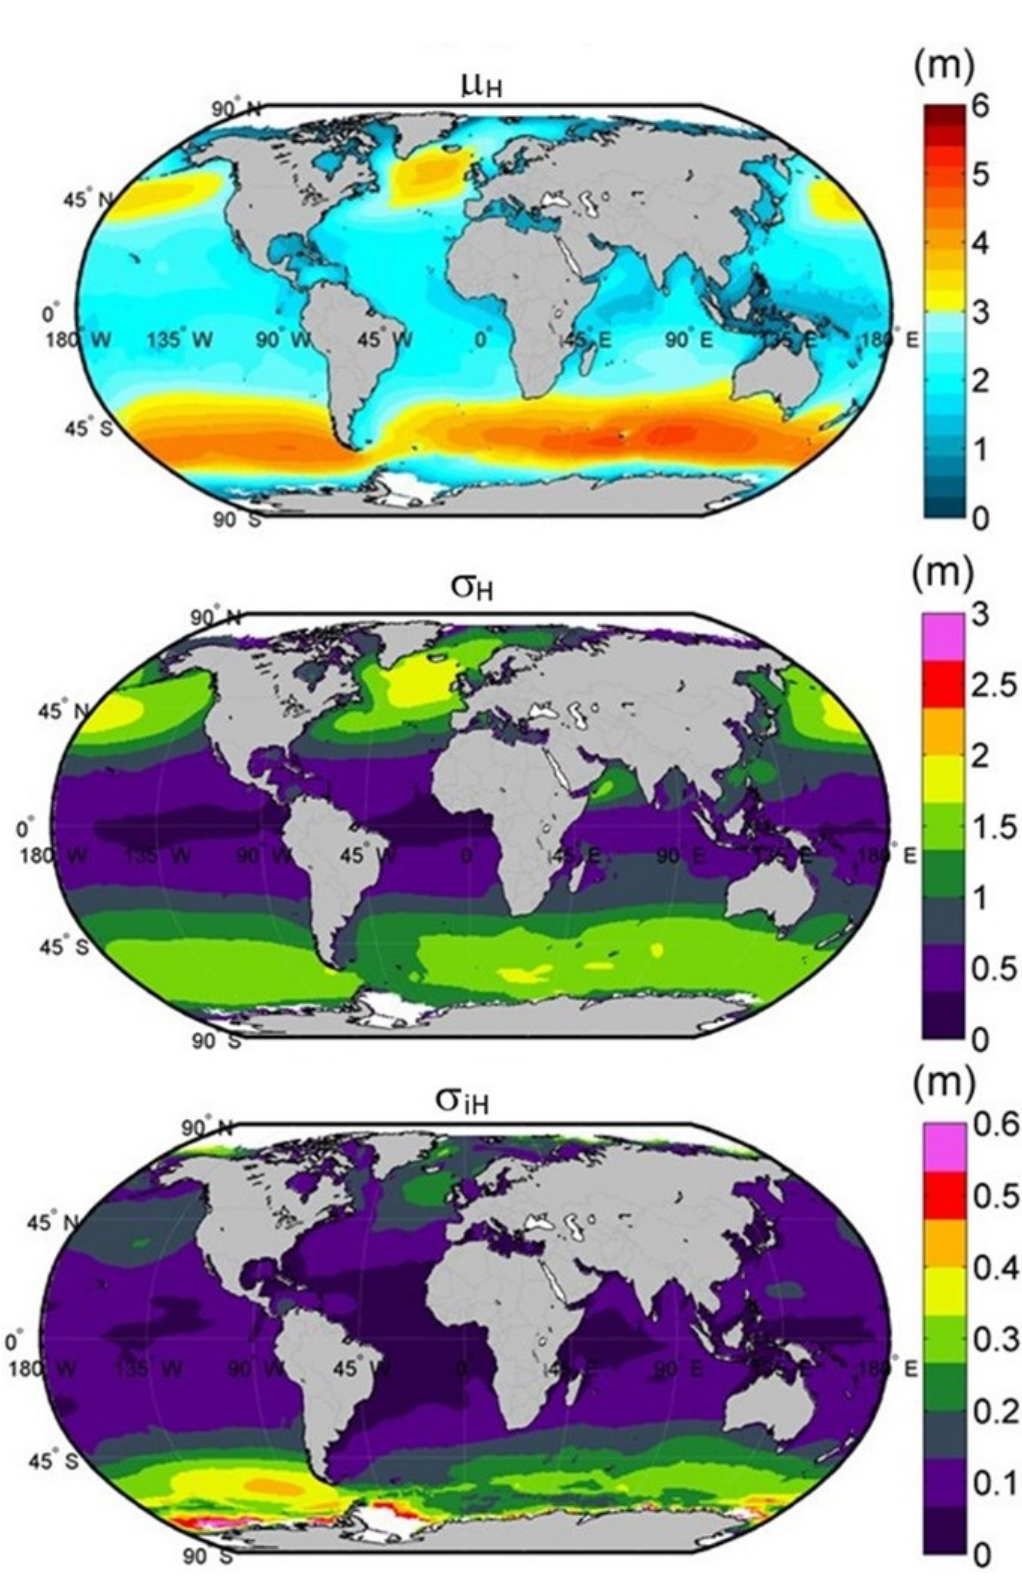
Figure 3. Global distribution of: mean significant wave height, μ H ( top ), standard deviation of the significant wave height, σ H ( centre ) and inter-annual standard deviation of significant wave height,